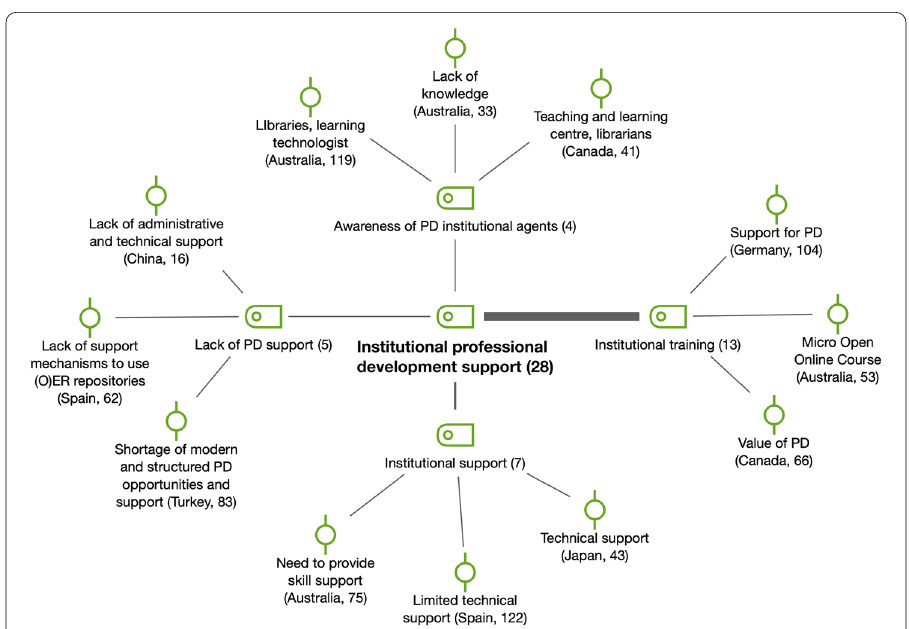
Fig. 10 Subcodes and examples for institutional professional development support (RQ4)